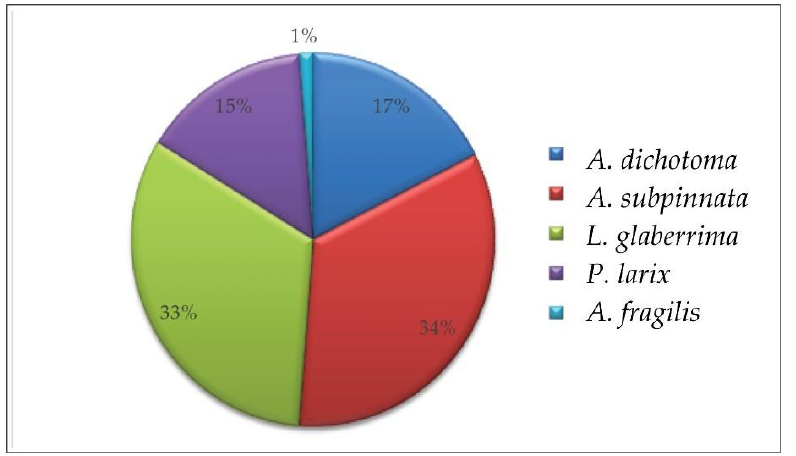
Figure 2. Percentages of black coral species observed in the Italian Seas.